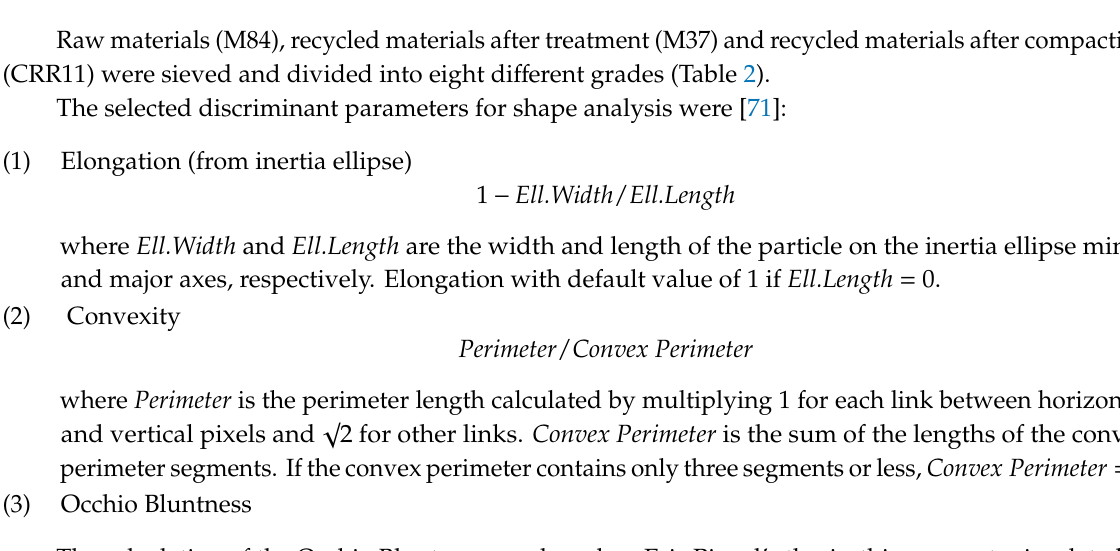
Figure 2. Occhio 500 Nano image analyser ( a ) and Occhio Bluntness values ( b ) [71].